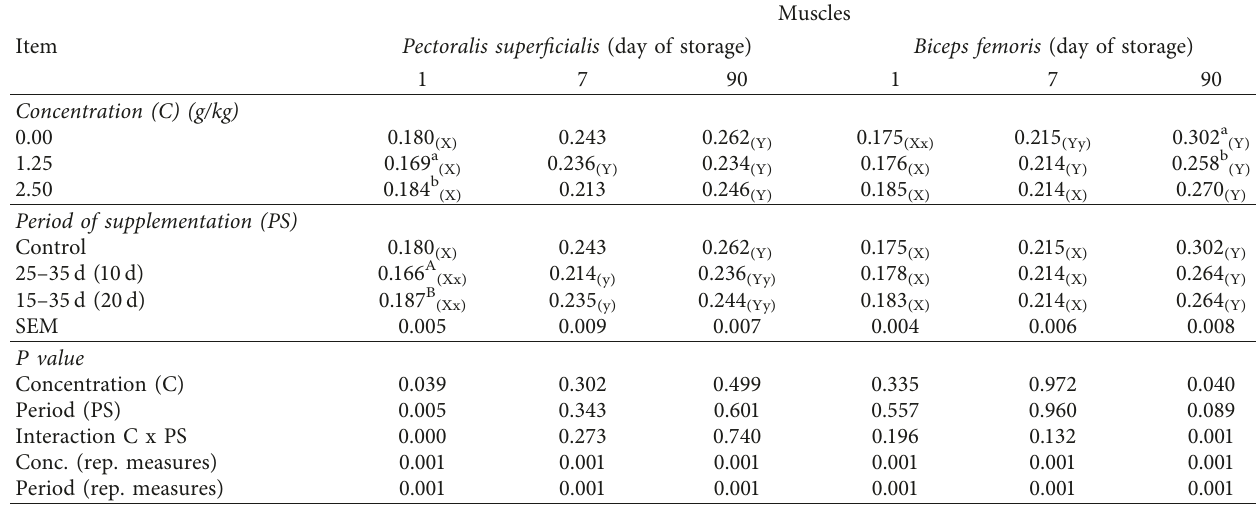
Table 4: TBA values presented as MDA content (mg/kg) in breast ( pectoralis superficialis ) and thigh ( biceps femoris ) muscles stored at 2-3 ° C for 1 and 7d or stored at − 18 ° C for